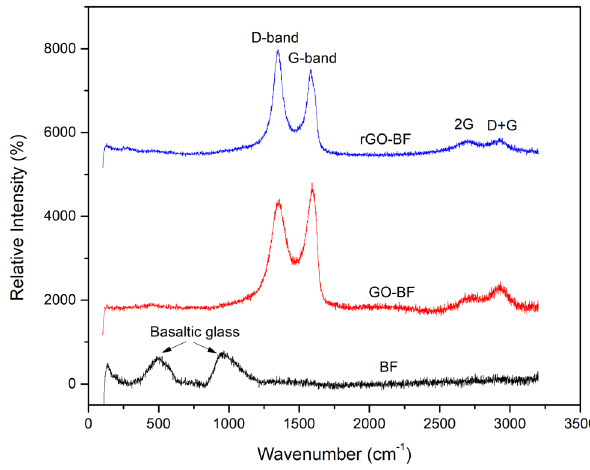
Figure 3: Raman spectra of bare BF, GO - coated BF ( BF - GO ) , and graphene - coated BF ( BF - rGO ) .